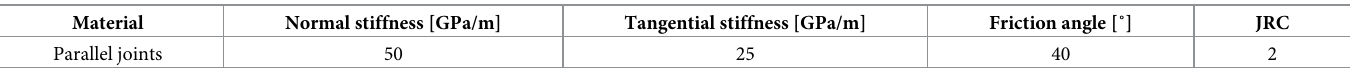
Table 3. Mechanical parameters of